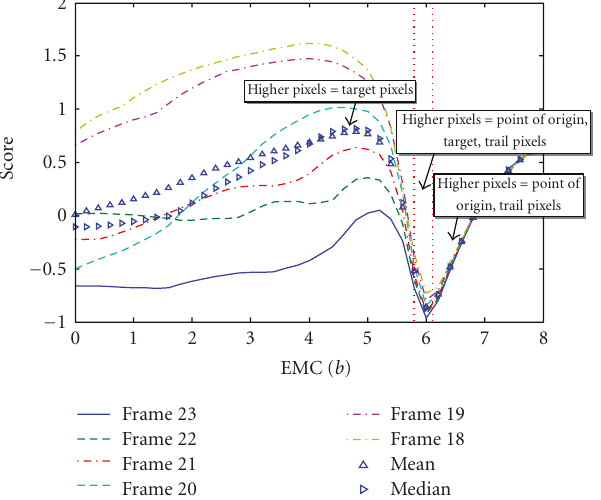
Figure 16: NA23A sequence, s n = 4, Max Numbers = 3, A S versus b , g = 0 case.